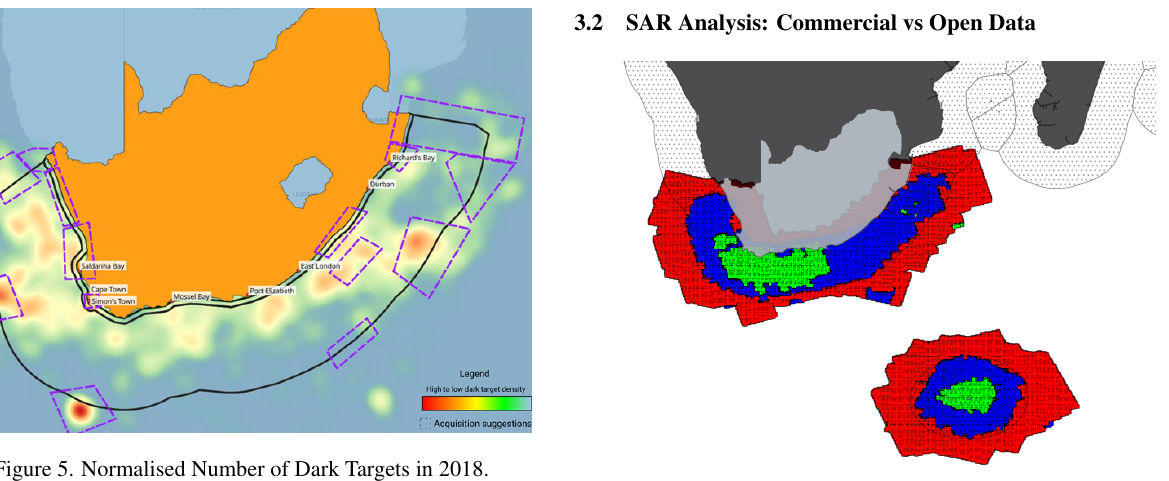
Figure 5. Normalised Number of Dark Targets in 2018.